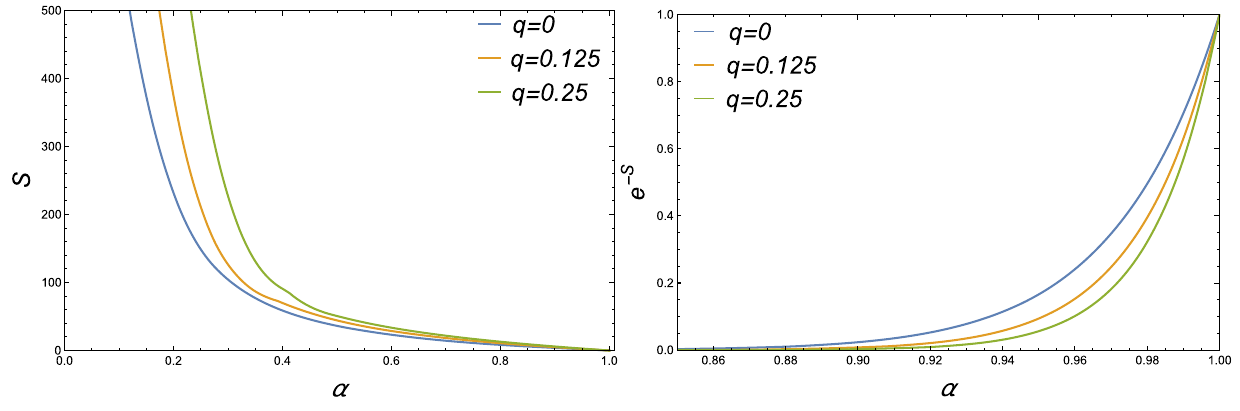
Fig. 7 The classical string action and its exponential behavior versus α in the D0–D4 background